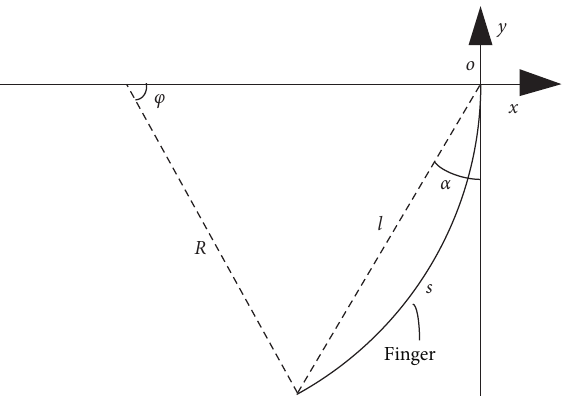
Figure 9: Finger bending analysis.